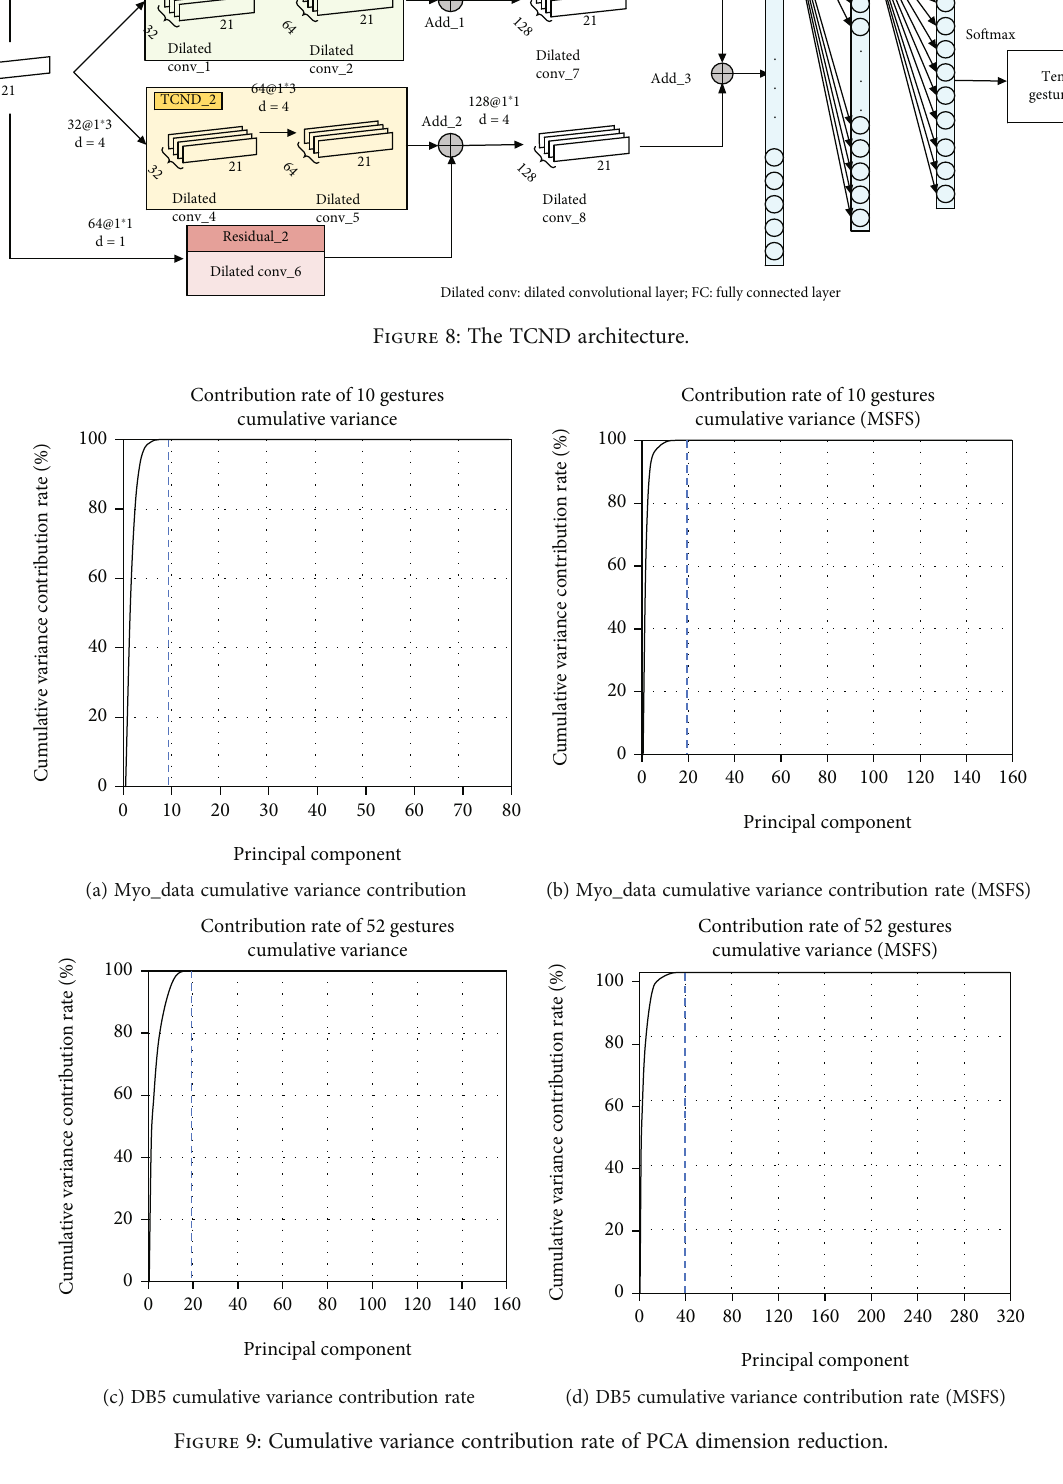
Figure 9: Cumulative variance contribution rate of PCA dimension